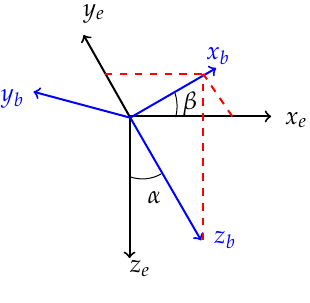
Figure 5. x e , y e and z e are the axes of the Cartesian coordinates. x b , y b and z b are the axes of the borehole coordinates. α and β are the dip and azimuthal angles,